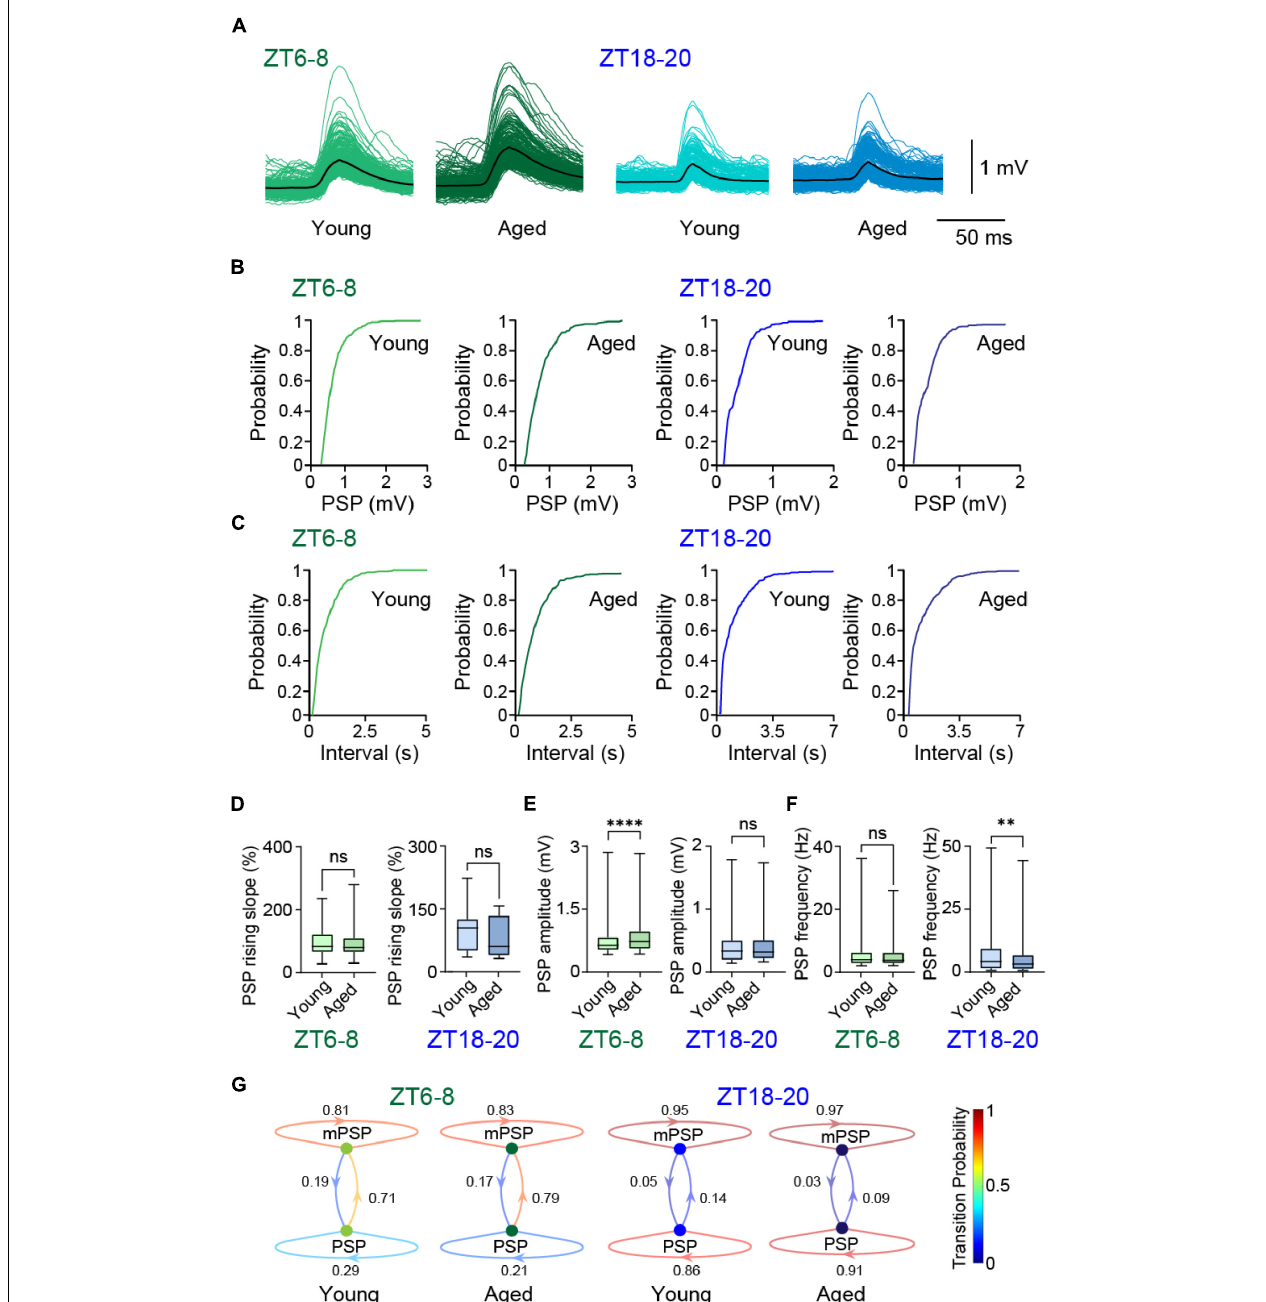
FIGURE 4 | Aging altered synaptic inputs in DN1p neurons. (A) Superimposed membrane potential traces based on postsynaptic potential (PSP) in young and aged DN1p neurons at ZT6–8 and ZT18–20. (B–E) Cumulative probability distributions of PSP amplitude (B) and inter-event interval values (C) ; quantification of relative rising slope of PSPs (D) , PSPs amplitude (E) , and PSPs frequency (F) ; and discrete-time Markov chain showing transition probability between estimated mPSP and PSP (G) in young and aged DN1p neurons at ZT6–8 and ZT18–20 (ZT6–8, young: n = 294 PSPs from N = 3 DN1ps, aged: n = 384 PSPs from N = 3 DN1p neurons; ZT-18–20, young: n = 333 PSPs from N = 3 DN1p neurons, aged: n = 391 PSPs from N = 4 DN1p neurons). ∗∗ p < 0.01 and ∗∗∗∗ p < 0.0001 based on Mann-Whitney U